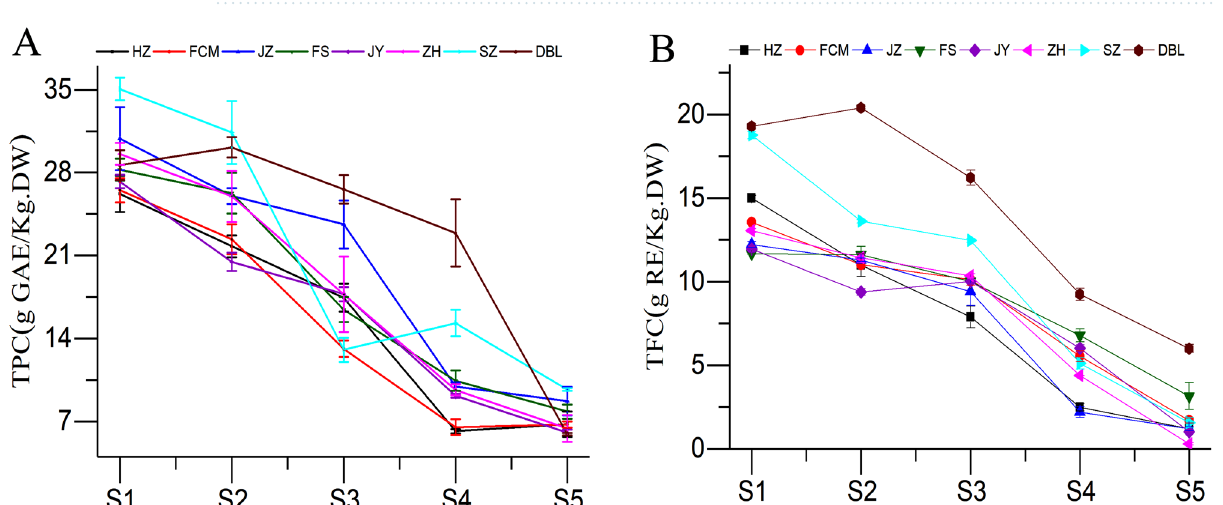
Figure 7. Changes in ( A ) total phenol content (TPC) and ( B ) total flavonoid content (TFC) of jujube fruit at various developmental